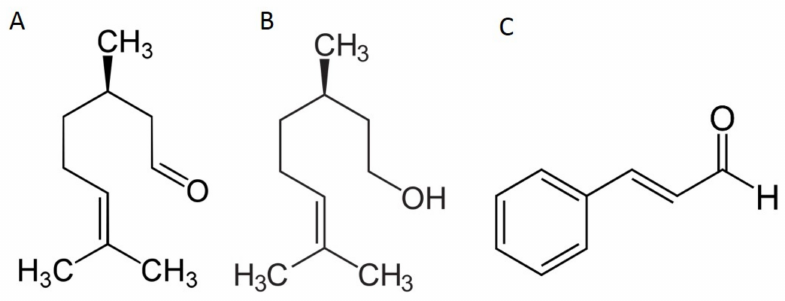
Figure 1. Structures of ( + )-citronellal (CitA) ( A ); ( + )-citronellol (CitO) ( B ); trans-cinnamaldehyde (CIN) ( C